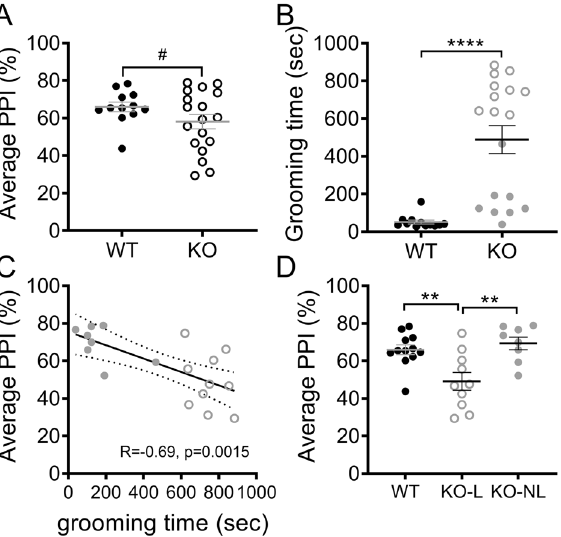
Figure 1. Disruption of PPI is associated with compulsive grooming phenotype in Sapap3-KOs. ( A ) PPI (average % across 3 prepulse intensities tested) did not differ between Sapap3-KO and WT mice. ( B ) Time spent grooming was significantly elevated in Sapap3-KO relative to WT, as previously described. Unfilled grey symbols denote KO-L, filled grey symbols denote KO-NL. ( C ) Average PPI was significantly negatively correlated with time spent grooming, suggesting disruption of PPI in Sapap3-KOs with the most severe compulsive grooming phenotype. ( D ) When Sapap3-KOs were separated based on the presence (KO-L) or absence (KO-NL) of lesions resulting from compulsive grooming, significant disruption of PPI in KO-L was revealed relative to WT and KO-NL (Bonferroni post-hoc tests: WT vs KO-L, p = 0.006; WT vs KO-NL, p > 0.99, KO-L vs KO-NL p = 0.003). In panel A, # indicates results of unpaired Welch’s T test, in panel B * indicates results of Mann–Whitney test, in panel D * indicate results of Bonferroni post-hoc test. **** p < 0.0001; ** p < 0.01; # p = 0.10. n = 12 WT, 18 KO (10 KO-L, 8 KO-NL). PPI prepulse inhibition, KO knockout, KO-L KOs with lesions, KO-NL KOs without lesions, WT